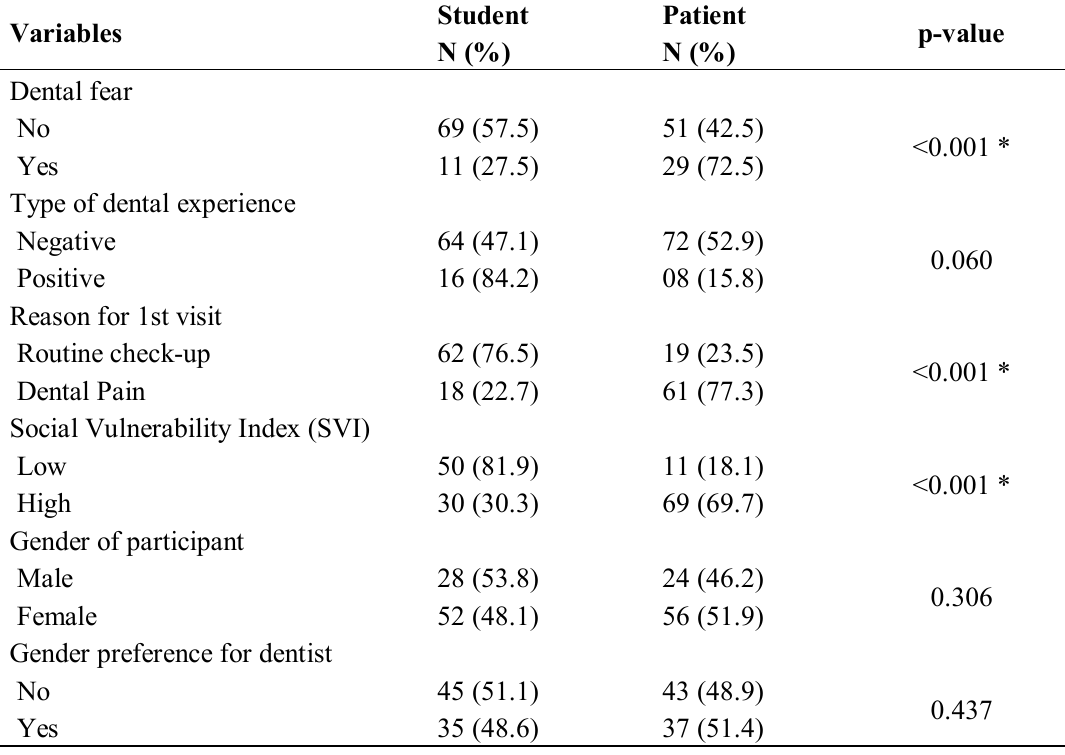
Table 1. Association of behavior between students and patients with